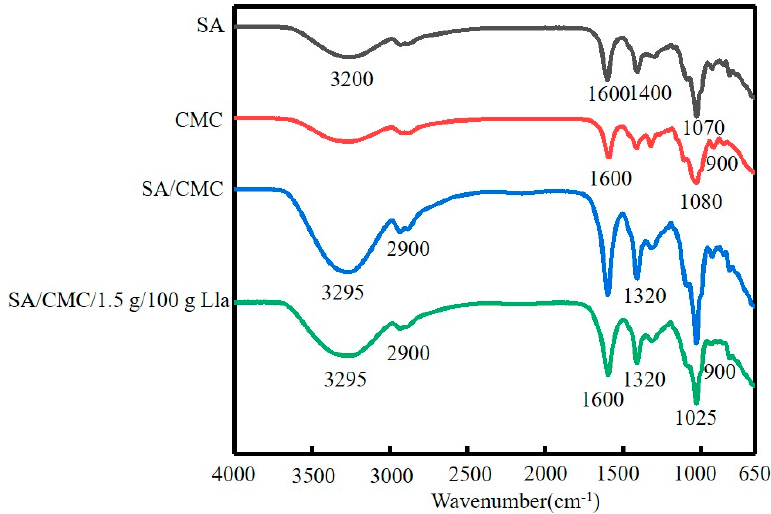
Figure 4. FT-IR spectra of SA, CMC, SA/CMC, SA/CMC/1.5 g/100 g Lla films.